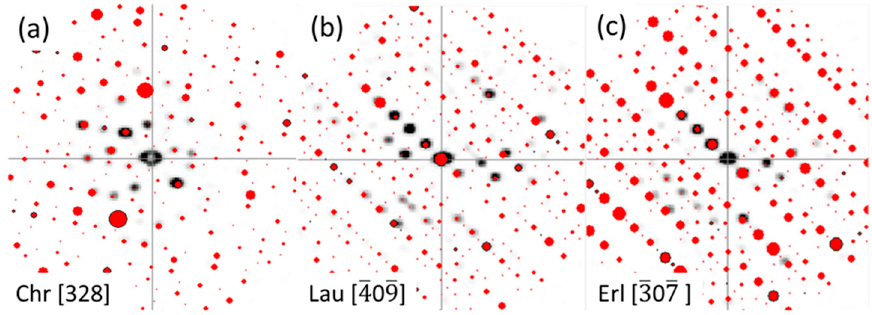
Figure 6. Precession Electron Diffraction (PED) patterns with their corresponding Miller indices corresponding to ( a ) chromite (Chr) and the associated ( b ) laurite (Lau) and the associated ( c ) erlichmanite (Erl) from the Os-rich zoning. Indexing intensities, phase identification and crystal orientation has been performed using the Astar TM software package.